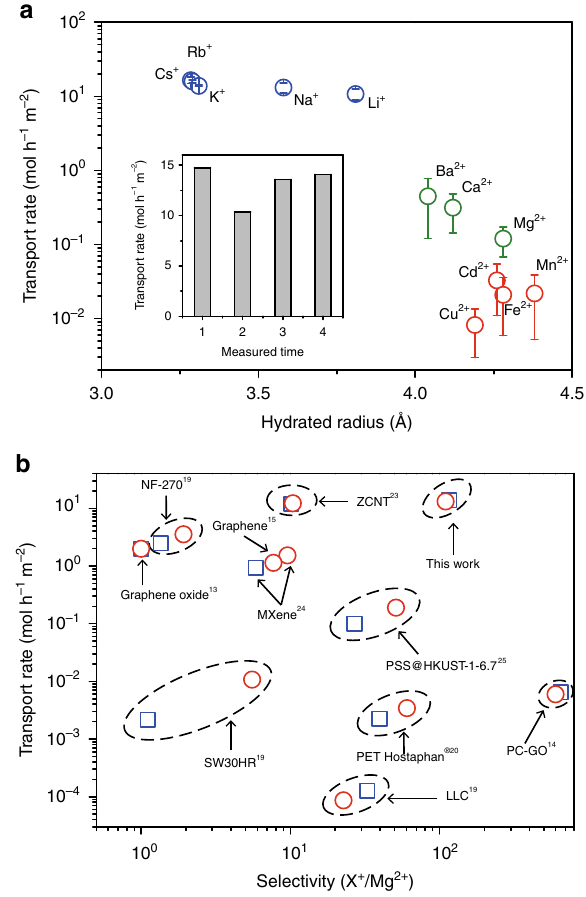
Fig. 1 Transport rates and selectivity. a Transport rates of alkali metal ions (blue), alkaline earth metal ions (green), and transition metal and heavy metal ions (red) measured with ICP, as a function of the hydration radius of the ions. The transport rates are normalized to a 1 M feed solution and measured under 10 V applied voltage. Error bars represent the standard deviation of at least three independent measurements using different membrane samples. The inset shows the transport rates of Na + ions of four independent measurements. Unless otherwise speci fi ed, the membranes were 2- µ m-thick PET Lumirror® membranes irradiated with 1.4-GeV Bi ions at a fl uence of 5 × 10 10 ions cm − 2 and subsequently exposed to UV radiation for 4 h. b Transport rates vs. selectivity of various nanoporous membranes; the ionic sieving membrane studied in this study outperforms in both transport rates and ionic selectivity of K + /Mg 2+ (blue) and Na + /Mg 2+